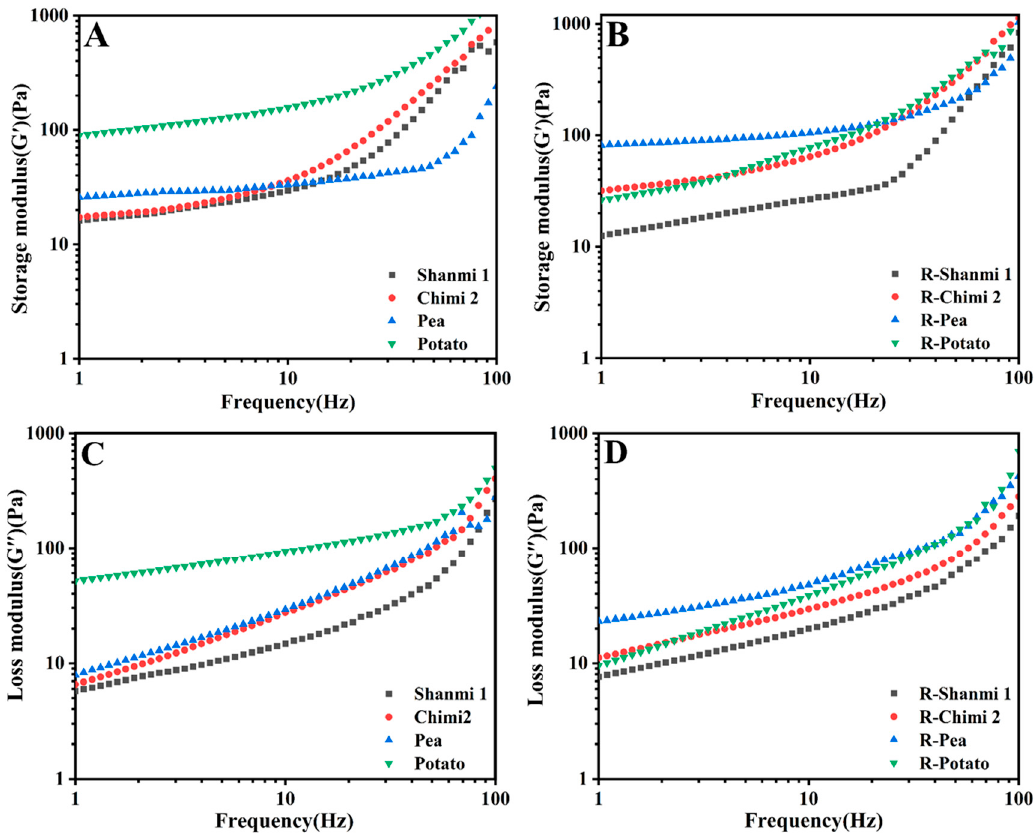
Figure 5. ( A ) Storage Moduli ( G’ ) of natural starch (NS); ( B ) Storage Moduli ( G’ ) of resistant starch (RS); ( C ) Loss Moduli ( G” ) of natural starch (NS); ( D ) Loss Moduli ( G” ) of resistant starch (RS).